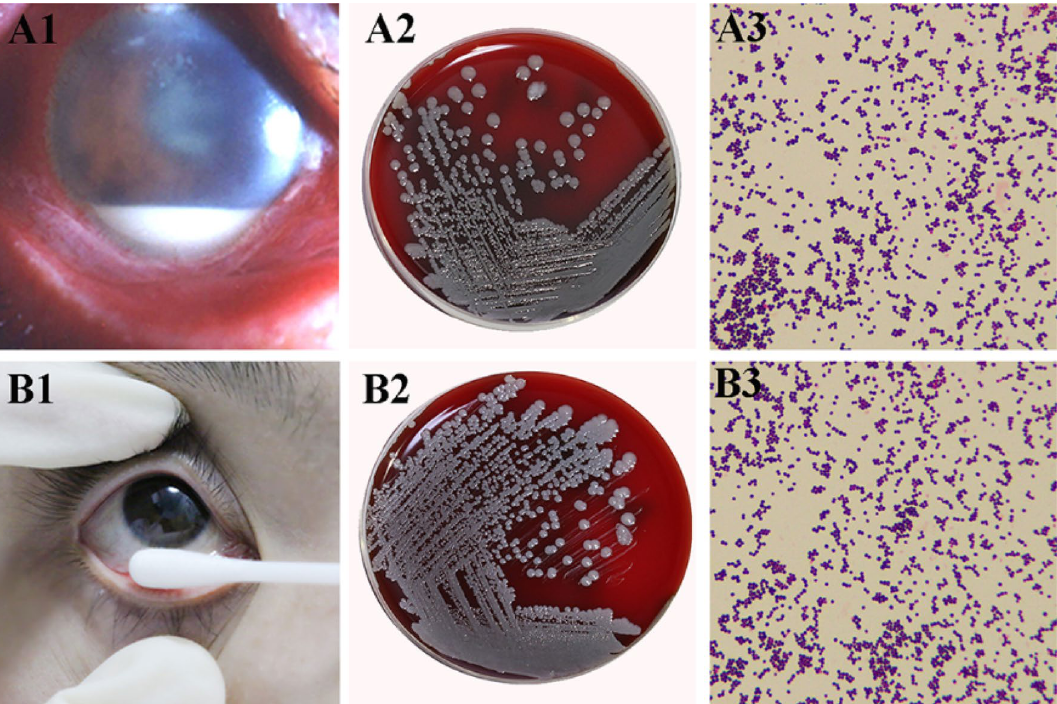
Figure 1. Preparation of S. epidermidis. ( A1 ) A slit lamp photo of a patient with postoperative endophthalmitis. ( A2 ) The positive sample of the vitreous after culture for 24 h on a blood agar plate identified as S. epidermidis by the automated microbiology system. ( A3 ) Gram staining (× 1,000). ( B1 ) A photo of the conjunctival swab for a healthy individual. ( B2 ) The positive sample after culture for 24 h on blood agar plate identified as S. epidermidis by the automated microbiology system. ( B3 ) Gram staining (×